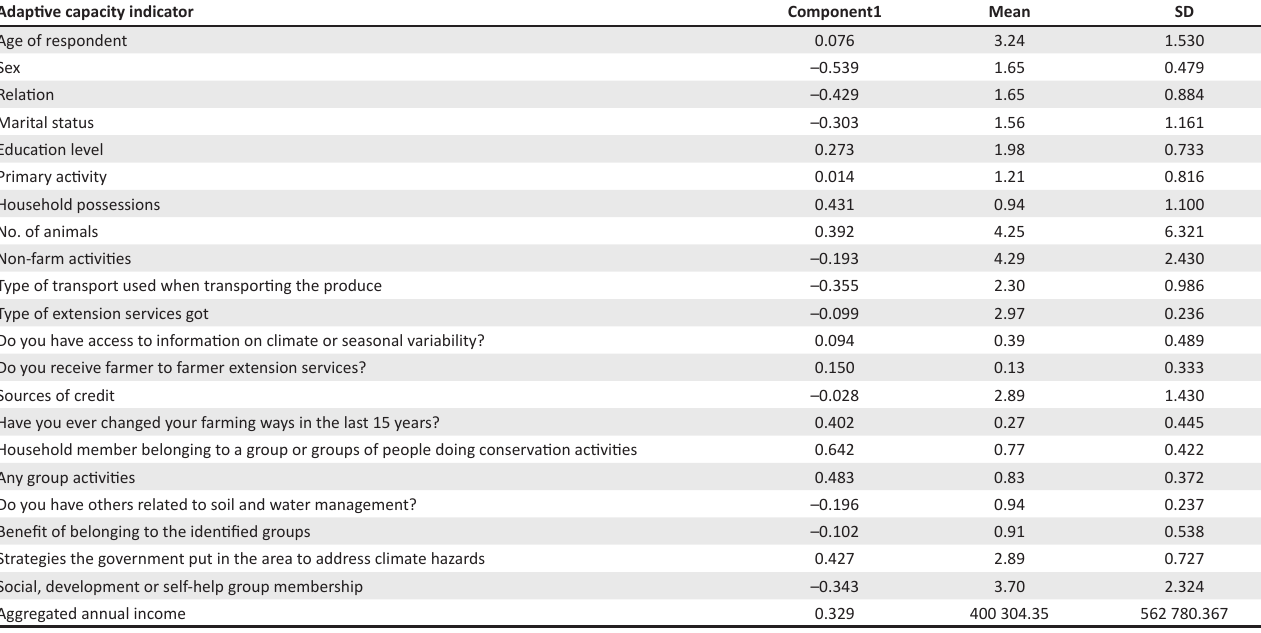
TABLE 5: Factor loadings for adaptive capacity. Adaptive capacity